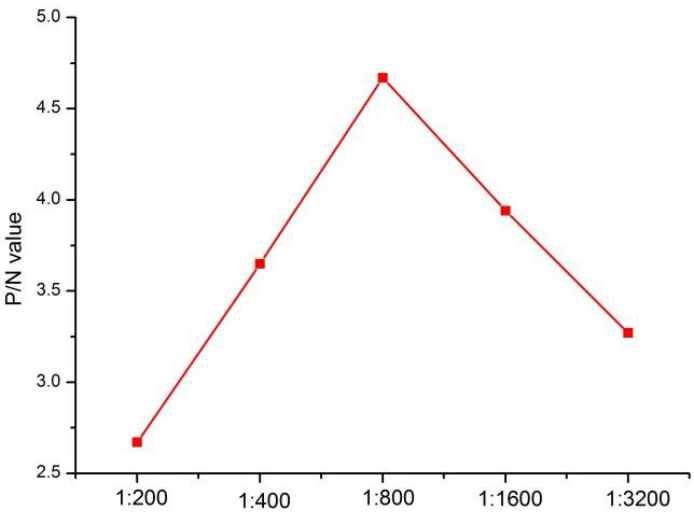
Figure 2. The optimization of the concentration of HRP-conjugated mAb 4.